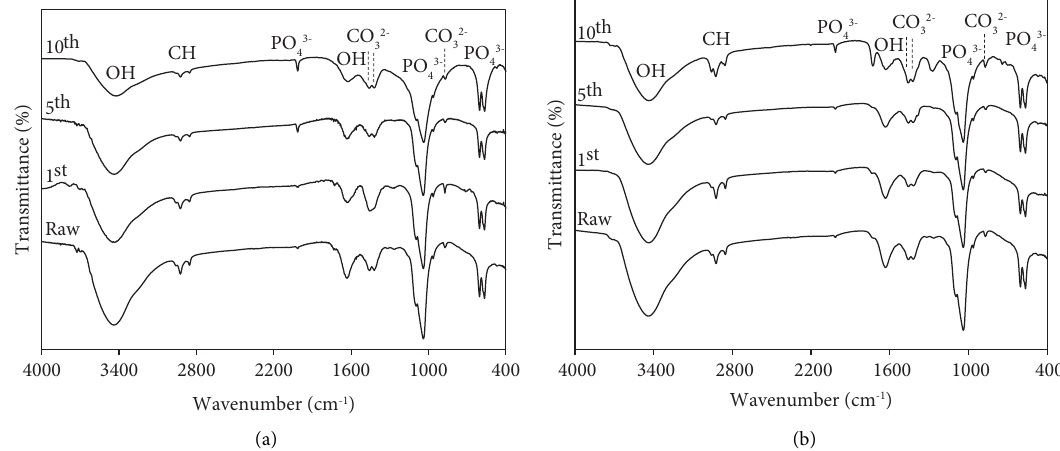
Figure 5: FTIR spectra of raw and regenerated bone chars (a) before and (b) after fuoride adsorption. Samples were regenerated with 0.075mol/L